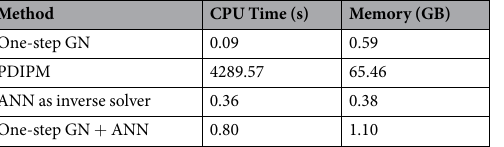
Table 2. CPU time and memory required to solve the EIT inverse problem from phantom data with different methods.